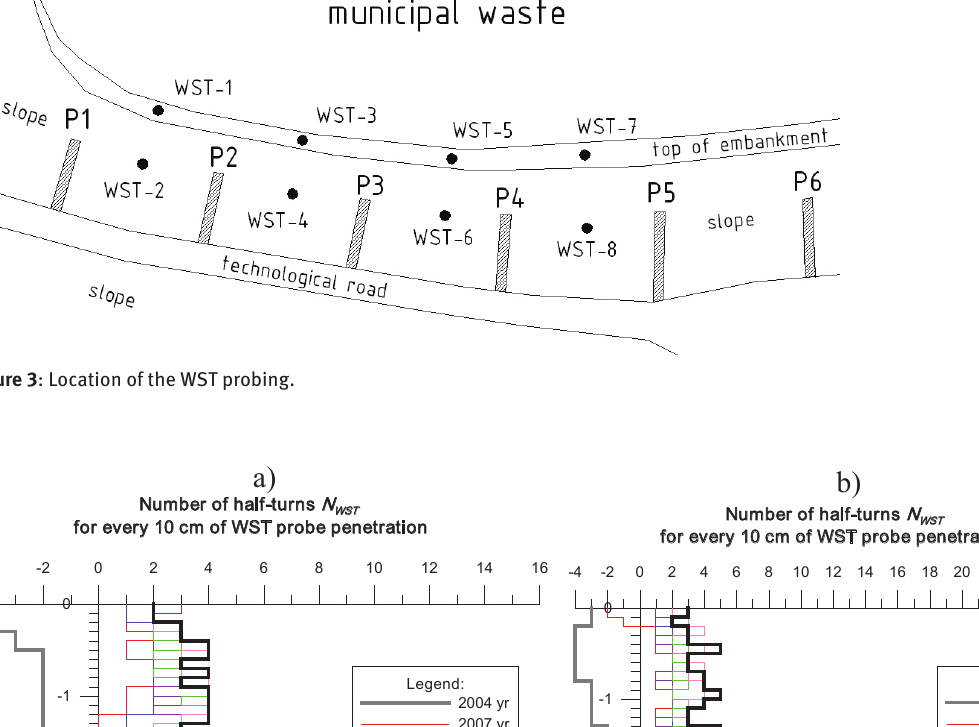
Fig. 1. Landfill cross section I – retaining embankment, II – geotechnical layer II, III – geotechnical layer III, IV – geotechnical layer IV, V – municipal waste, VI – organic layer a) b) Fig. 2. Landfill retaining embankment a) damaged, 2004 b) after repairs with counterforts P1 ÷ P5, 2005